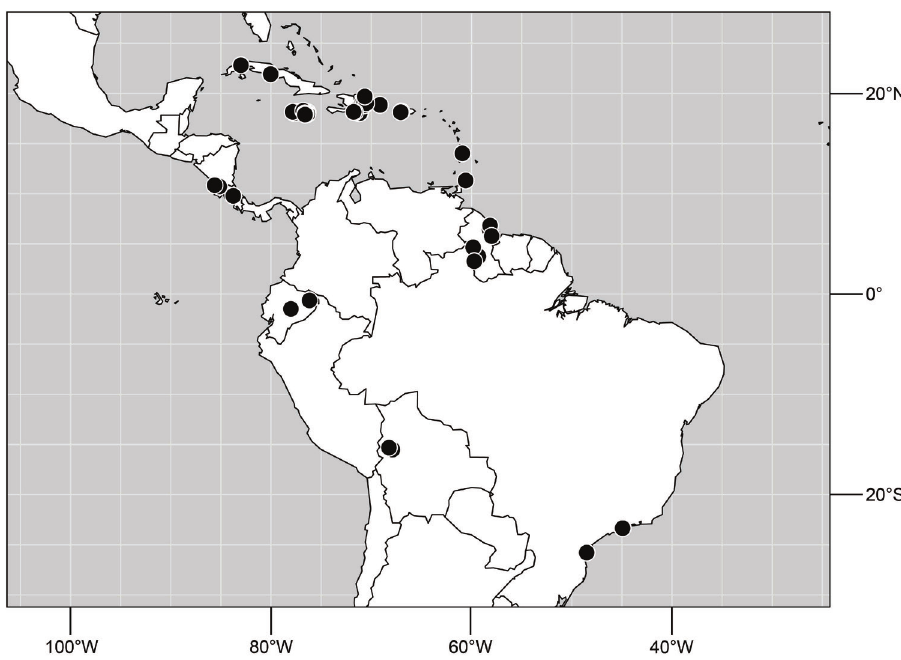
Figure 161. Distribution of Hydrochasma capsum sp.